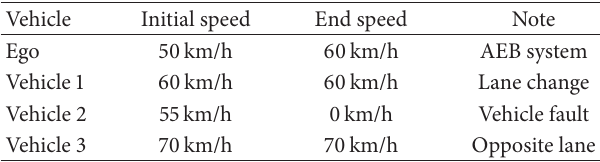
Figure 11: Limitations of vehicle-mounted sensor. Table 4: Simulation